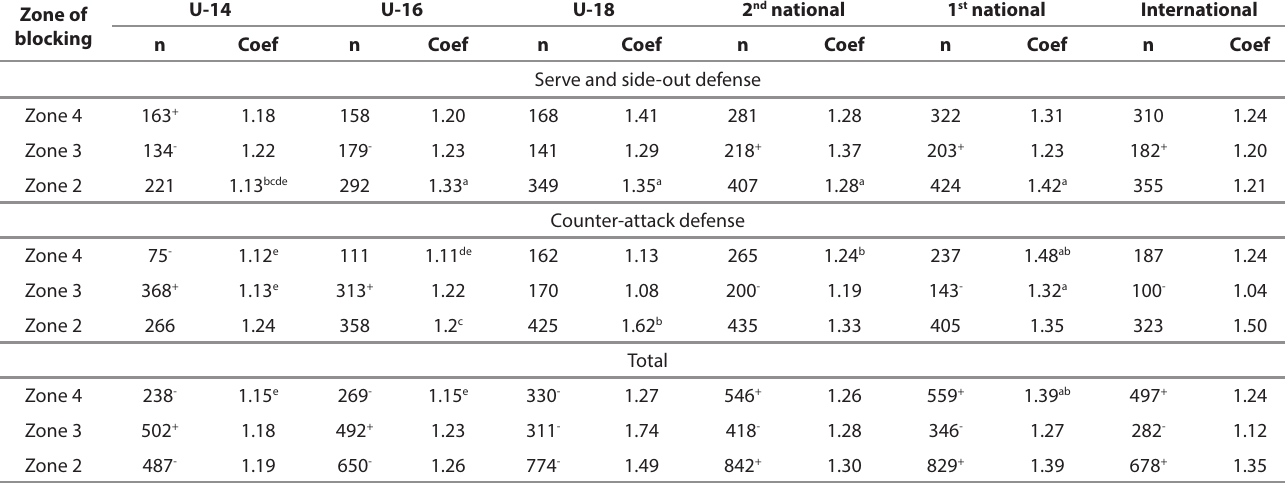
TABLE 5. Efficiency of the block according to game phase, zone and levels of competition (women’s volleyball) Zone of